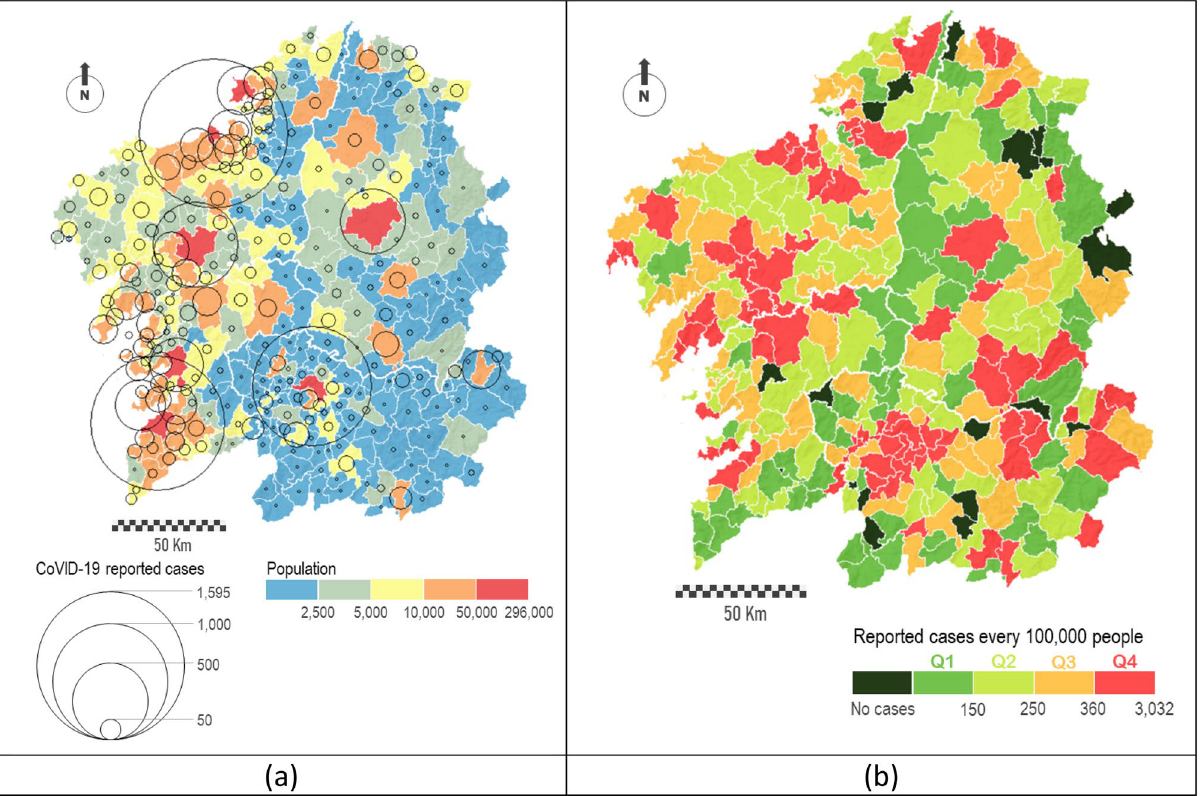
Figure 2. Geographical spread of COVID-19 in Galicia at a municipal level: ( a ) Reported cases versus total population, and ( b ) Incidence rate. Maps are generated using ArcGIS Desktop software version 10.8 (from ESRI, https:// www. esri. com/ en- us/ arcgis/ produ cts/ arcgis- deskt op/ overv